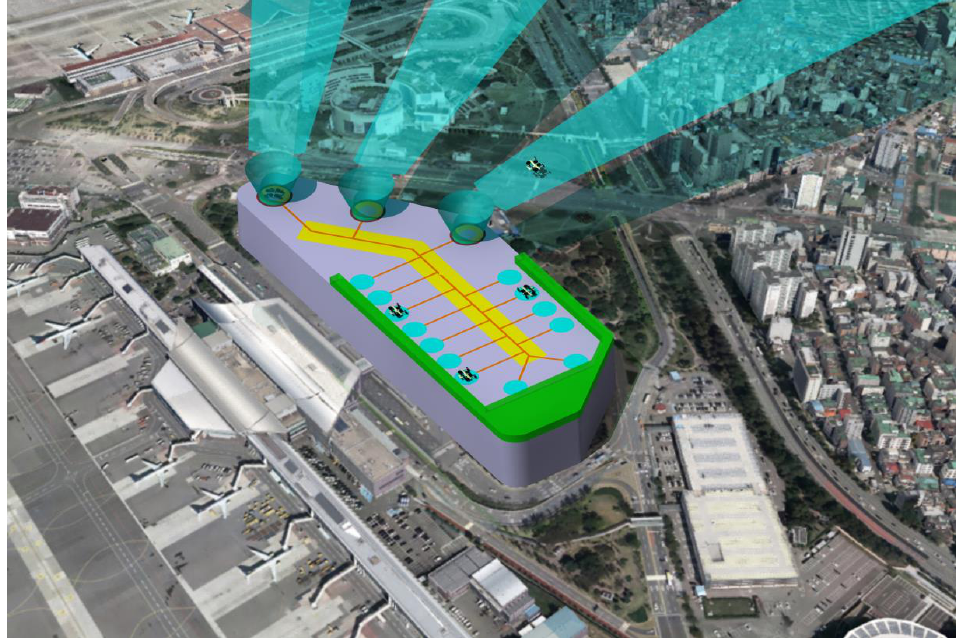
Figure 39. Example of vertiport approach/departure surfaces with the EASA’s regulations for a pier topology at the current Gimpo Airport parking lot.